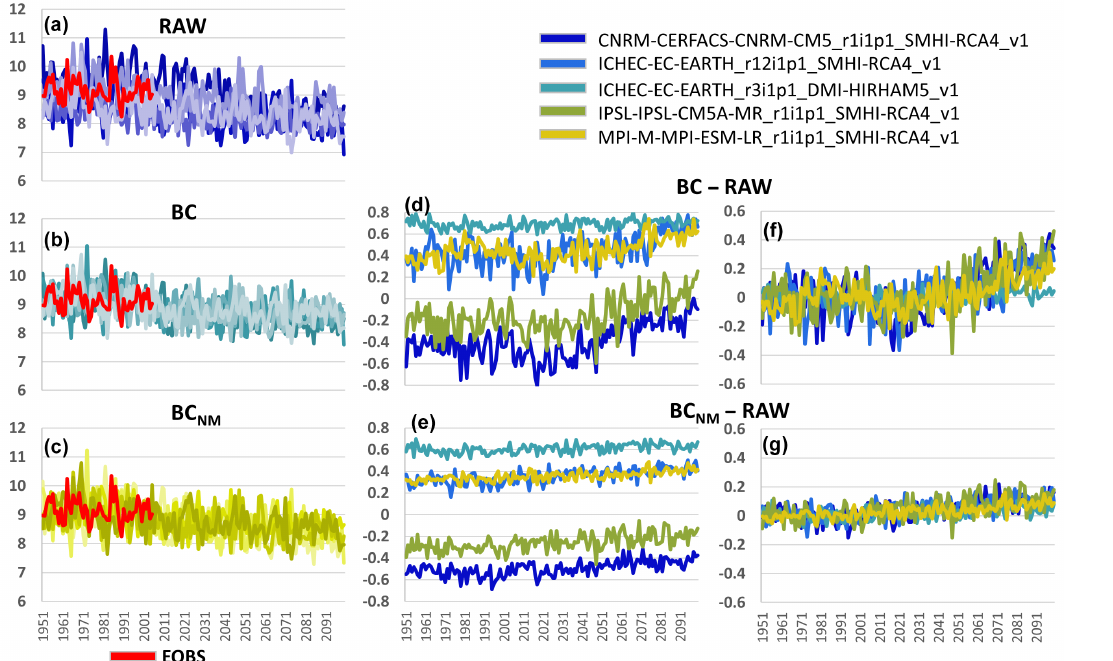
Figure 9. Average of standard deviations for the study domain, for the raw data (a) , the BC (b) and the BC-NM (c) for the different models and the observations, on an annual basis. Differences between the raw and the bias-corrected standard deviations are shown in (d) and (e) . Plots (f) and (g) correspond to the same data as (d) and (e) , but normalized for their 1951–2005